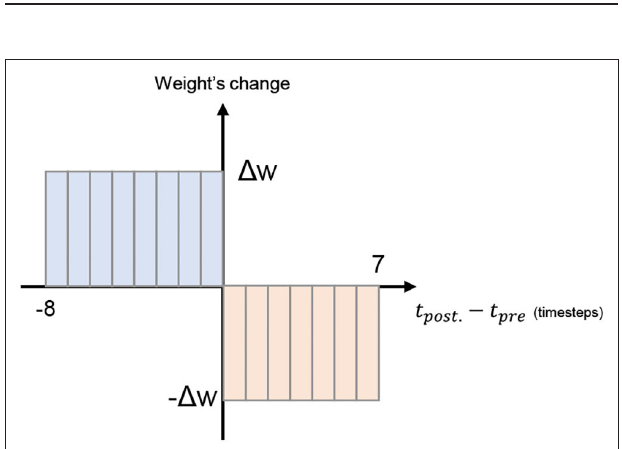
FIGURE 8 | On-chip STDP learning